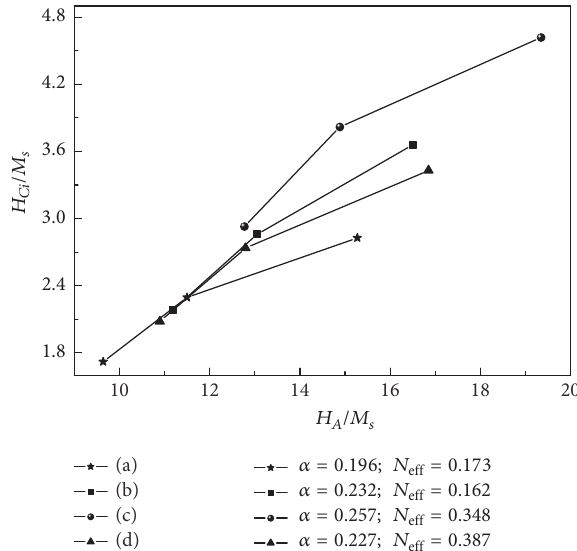
Figure 6: Dependence of 𝐻 𝐶𝑖 /𝑀 𝑠 on 𝐻 𝐴 /𝑀 𝑠 for Ta/Nd/NdFeB ( 𝑥 nm)/Nd/Ta ((a) 𝑥 = 450 ; (b) 𝑥 = 600 ; (c) 𝑥 = 750 ; (d) 𝑥 = 900 )